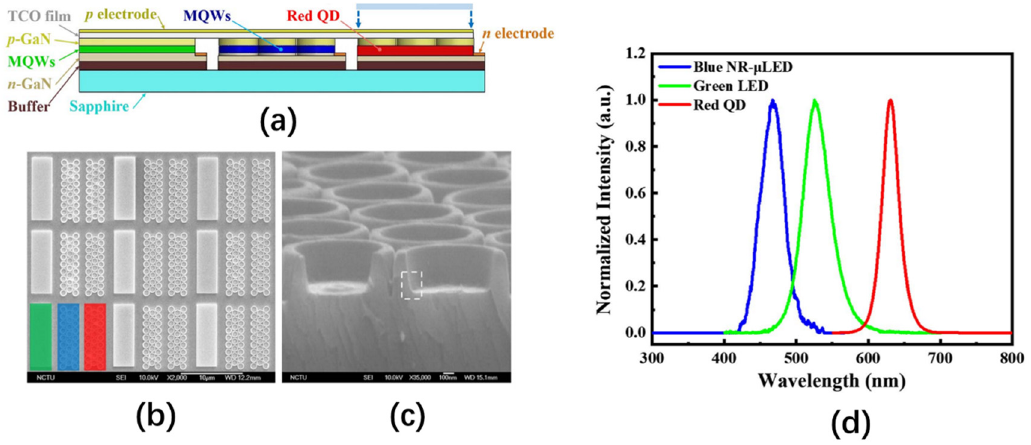
Figure 21. ( a ) Structure of the nano-ring (NR)-QD-micro-LED; ( b , c ) are the SEM images of the RGB pixel array and the nanostructure, respectively; ( d ) is the RGB NR-QD-micro-LED normalized EL spectrum. Reproduced from [121], with permission from Photonics Research, 2017.